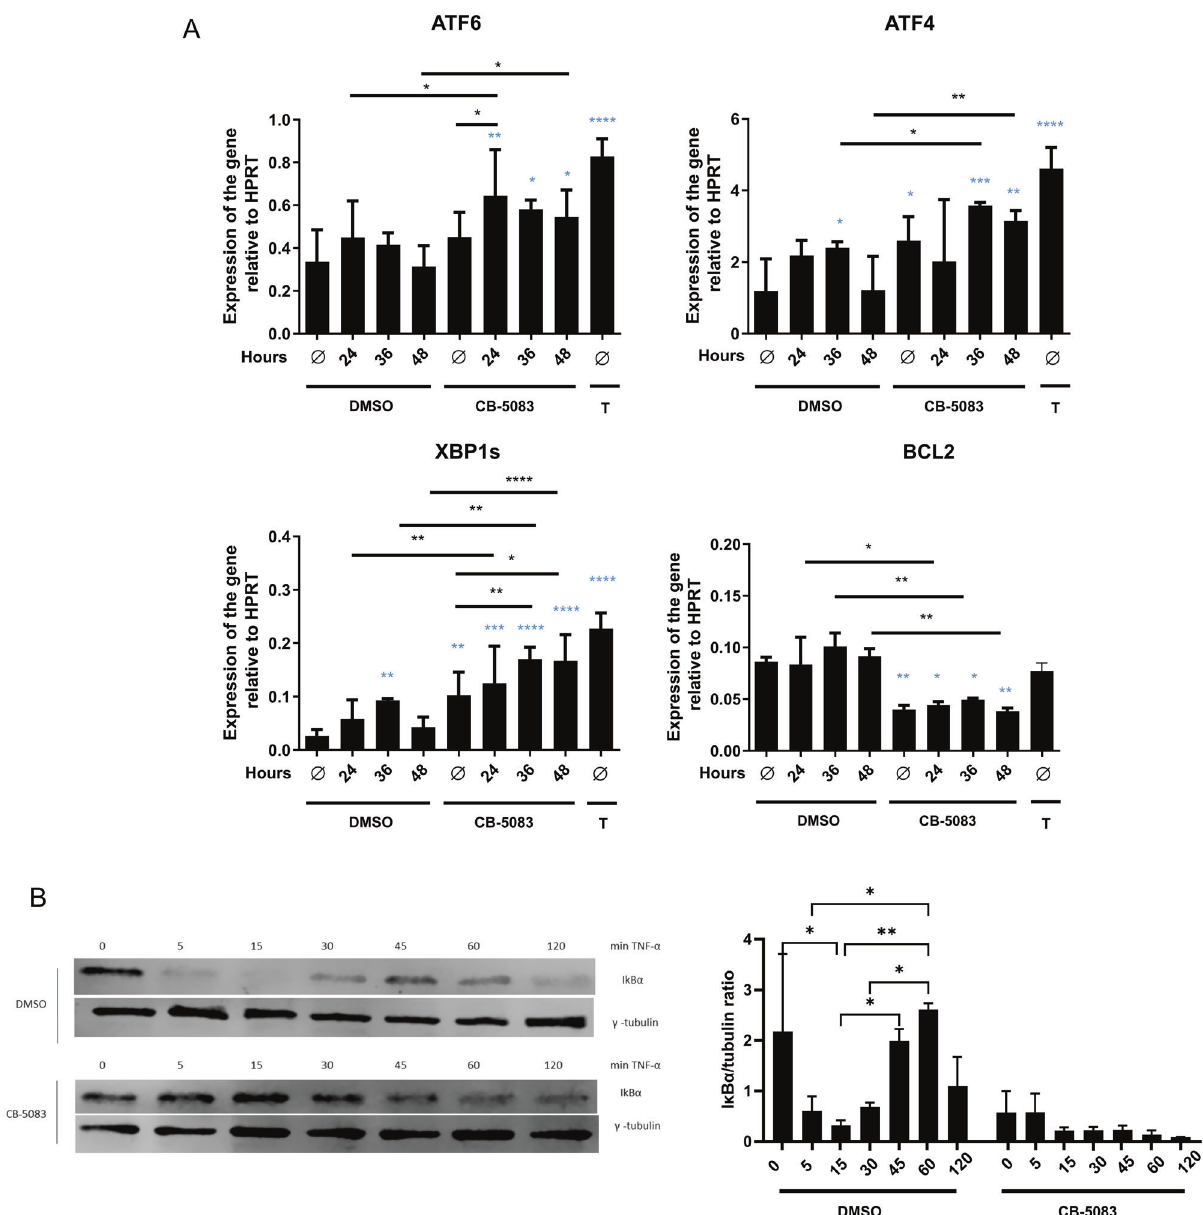
Fig. 2 Unfolded protein response induction and cytokine-induced degradation of I κ B α by CB-5083. A MC57 cells were infected with LCMV for 24, 36, and 48 h or left uninfected (Ø). 6 h before harvesting the cells they were treated with 5 µM CB-5083 or DMSO. As a positive control, uninfected cells were treated with 4 µg/ml of tunicamycin (T) for 6 h. The relative expression of the indicated genes analyzed by real-time RT- PCR is shown. The data was normalized to HPRT. A two-way ANOVA followed by a Fisher ’ s LSD test was performed. The statistical comparison of the data with the uninfected DMSO-treated sample is depicted in blue color. Data were pooled from four independent experiments. B MC57 cells were incubated with DMSO or 5 μ M CB-5083 for 6 h. Then the cells were stimulated with 200 U/ml TNF- α and harvested at indicated time points. Samples were lysed and an SDS-PAGE and immunoblot for I κ B α were performed. γ -tubulin was used as a loading control. The experiment was repeated twice yielding similar results. Data was pooled from two independent experiments and analyzed by a two-way ANOVA followed by Tukey test. All values represent mean ± SD. * p < 0.05, ** p < 0.01, *** p < 0.001, and **** p <